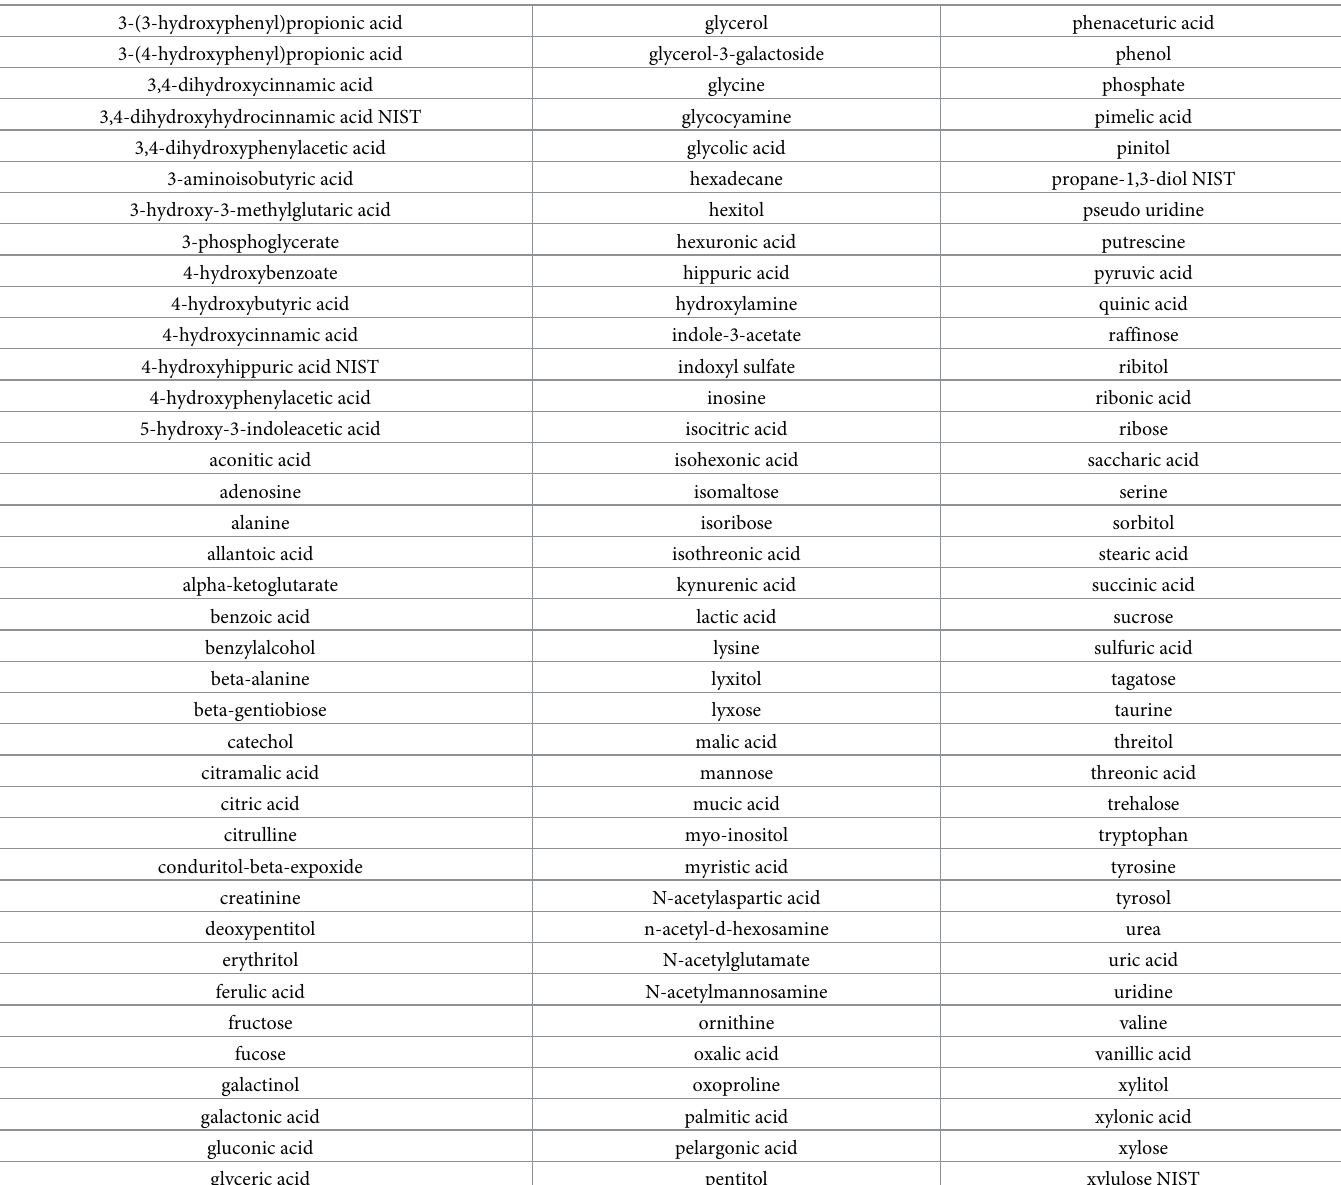
Table 1. List of 114 low molecular-weight molecules identified in feline urine in the training data set using an untargeted metabolomics